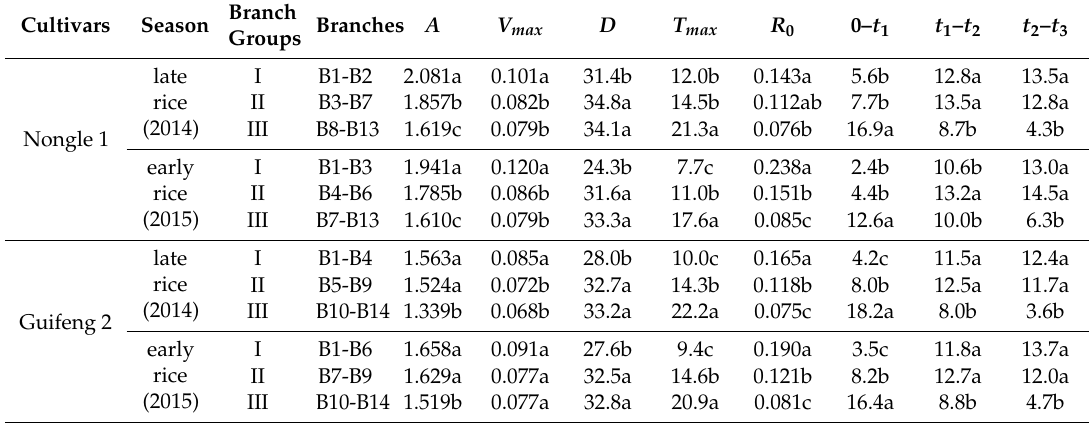
Table 4. Comparison of grain growth parameters at di ff erent primary-branch groups of Nongle 1 and Guifeng 2 in 2014 and 2015. Means followed by the same letters within the column are not significantly di ff erent at p <